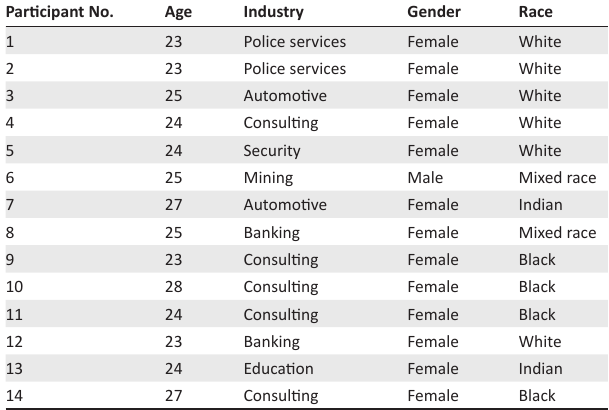
TABLE 2: Characteristics of industrial and organisational psychology intern